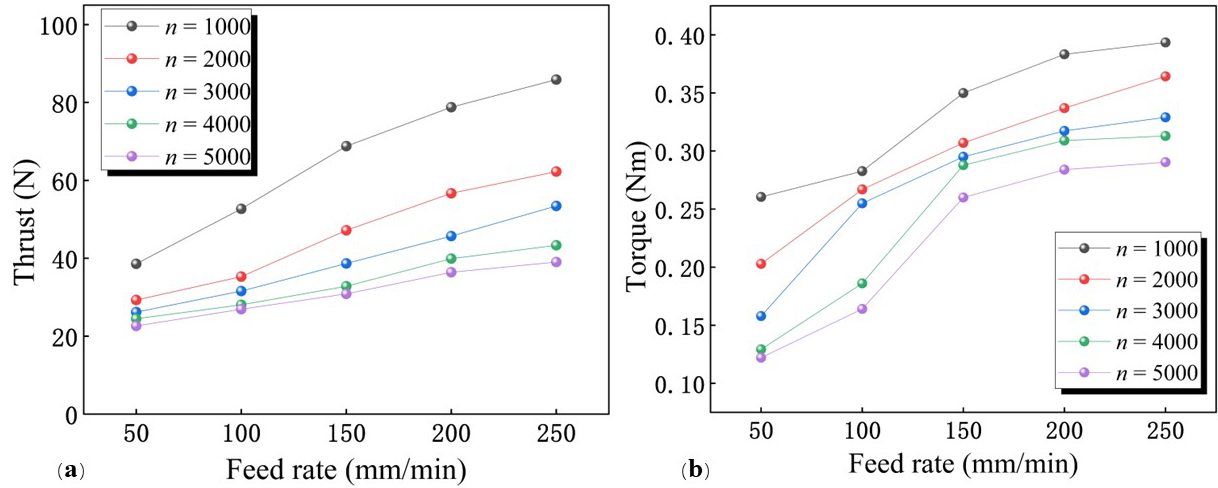
Figure 5. Variation curves of thrust and torque at different cutting parameters. ( a ) Thrust; ( b ) Torque.